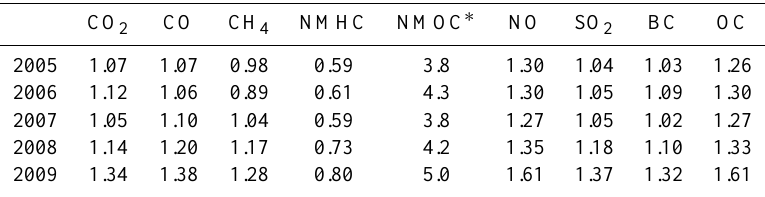
Table 9. Comparison of FINNv1 and the annual output from GFEDv3.1. The values here represent the ratio of the annual average FINNv1 emissions to the GFEDv3.1 emissions. CO 2 CO CH 4 NMHC NMOC ∗ NO SO 2 BC